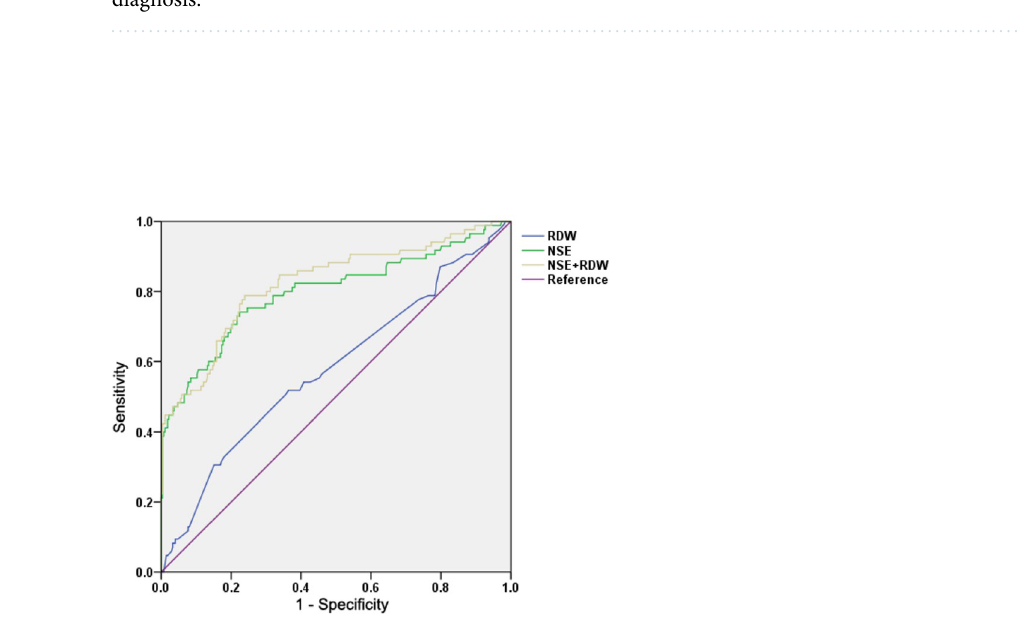
Table 1. Diagnostic value of RDW alone, CEA alone and Cyfra21-1 alone and combined detecting for NSCLC diagnosis.